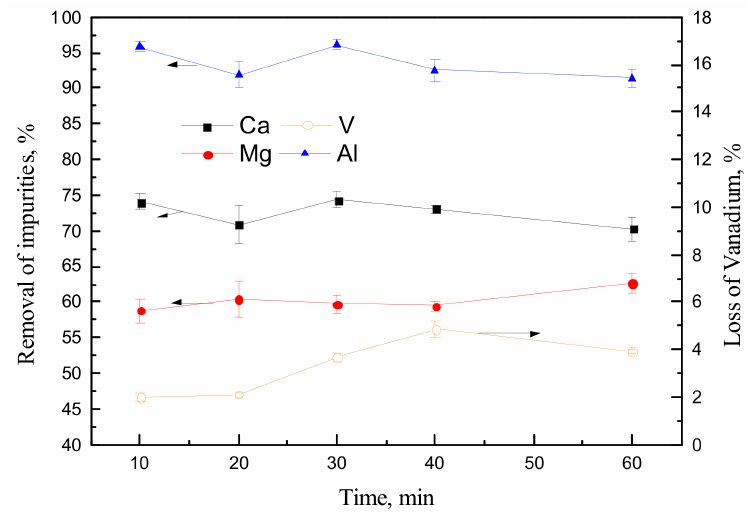
Figure 5. Purification efficiency of the vanadium-bearing solution using the prepared precipitant of MnNH 4 F